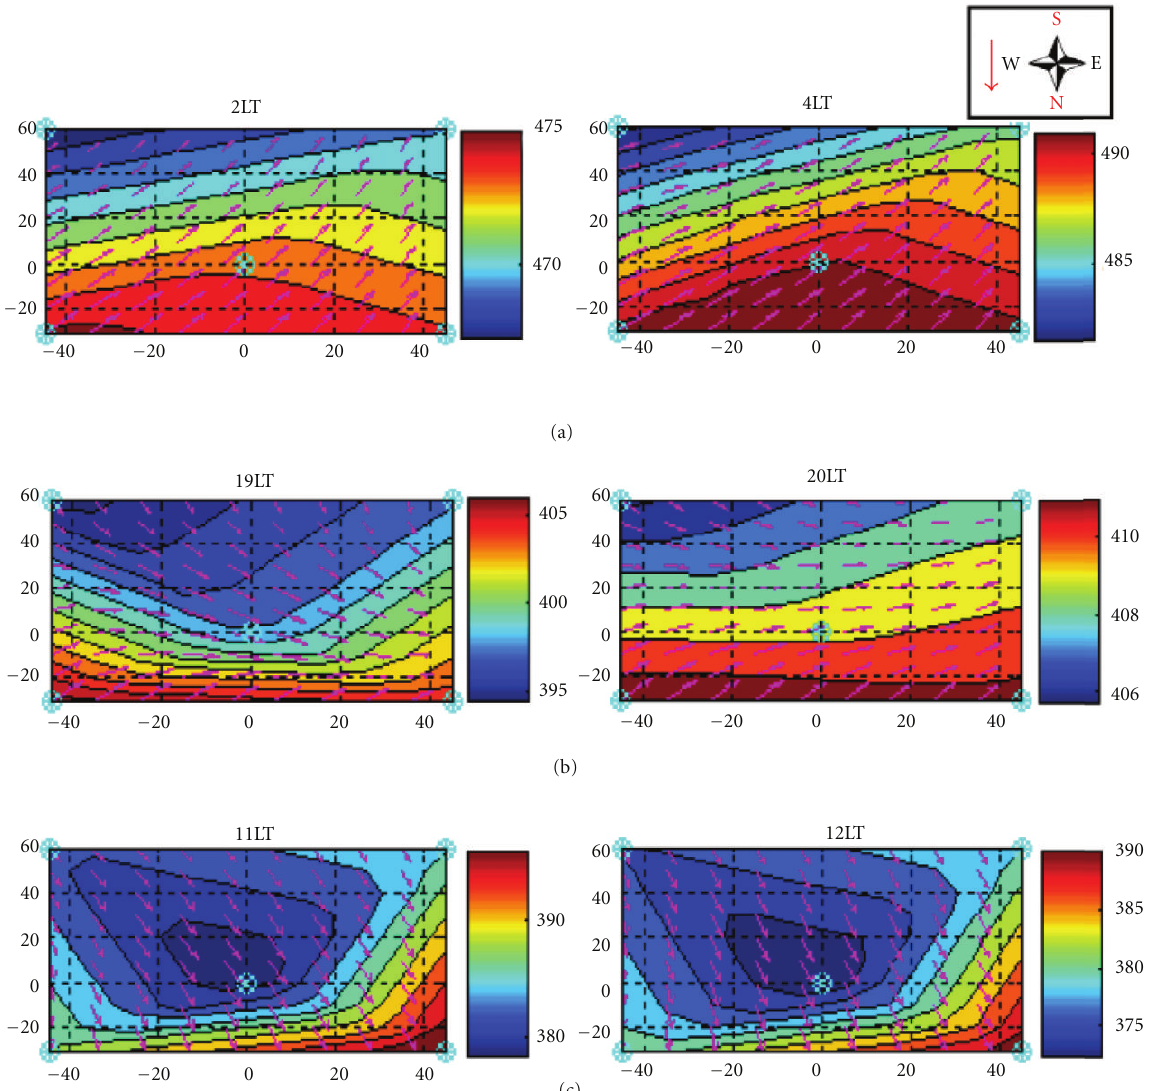
Figure 17: Hourly average of the subcanopy (2m) CO 2 concentration and horizontal wind speed over the DRAINO system south face area during dry period of the year 2006 note the geographic orientation and the red arrow indicating slope inclination (see Figure 4). The axis represents distances from center of the main tower. Daytime (a), transition period—evening (b), established nighttime